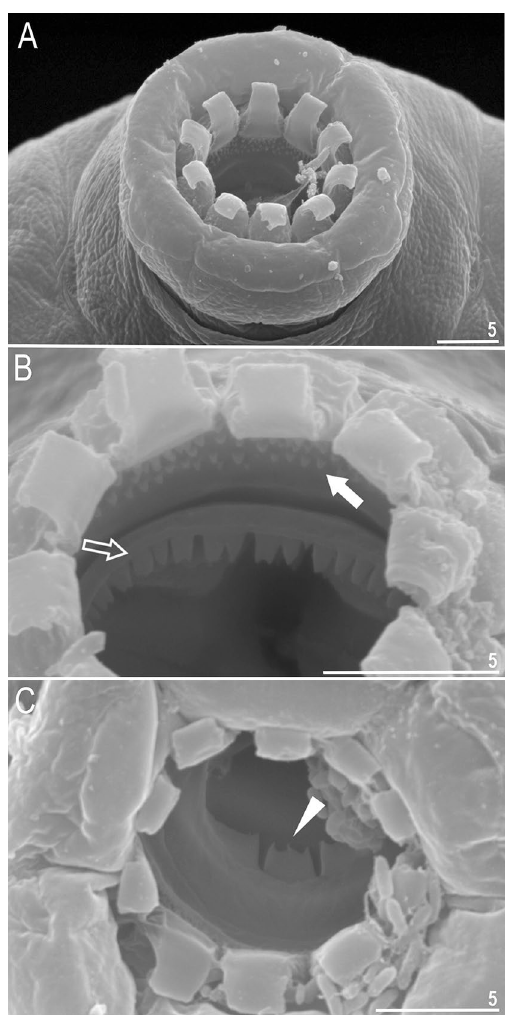
Figure 6. Paramacrobiotus gadabouti sp. nov.: ( A )—mouth with ten peribuccal lamellae (paratype, SEM); ( B )—oral cavity armature with first and second band of teeth (paratype, SEM); ( C )—oral cavity armature with third band of teeth (paratype, SEM) from dorsal side. Filled arrow represents first band of teeth, empty arrow represents second band of teeth and filled unindented arrowhead represents third band of teeth. Scale bars in